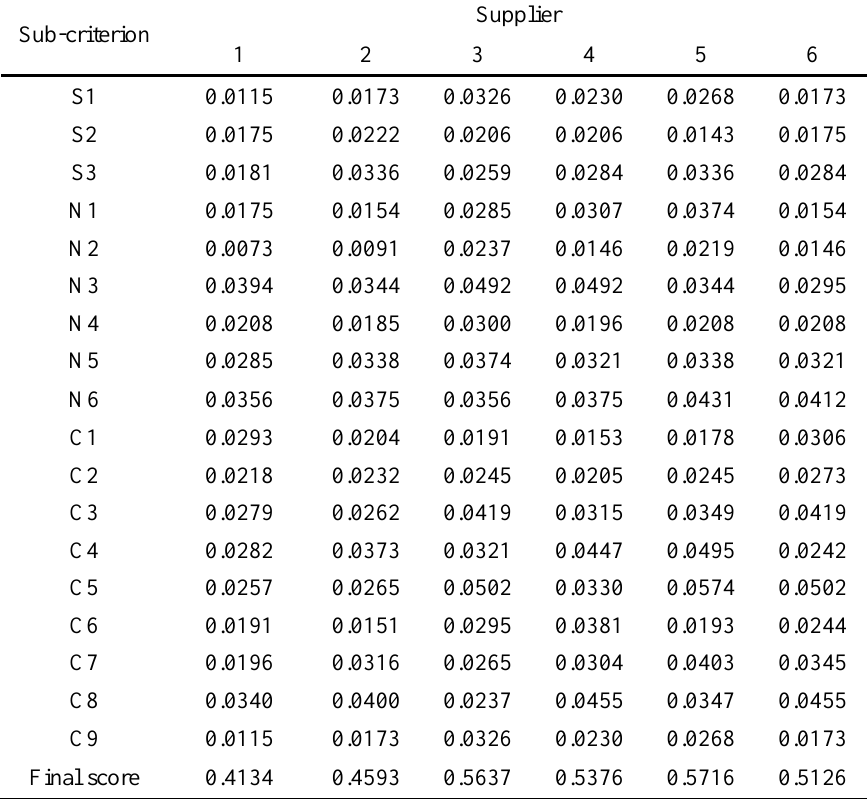
Table 7. The final score of suppliers.